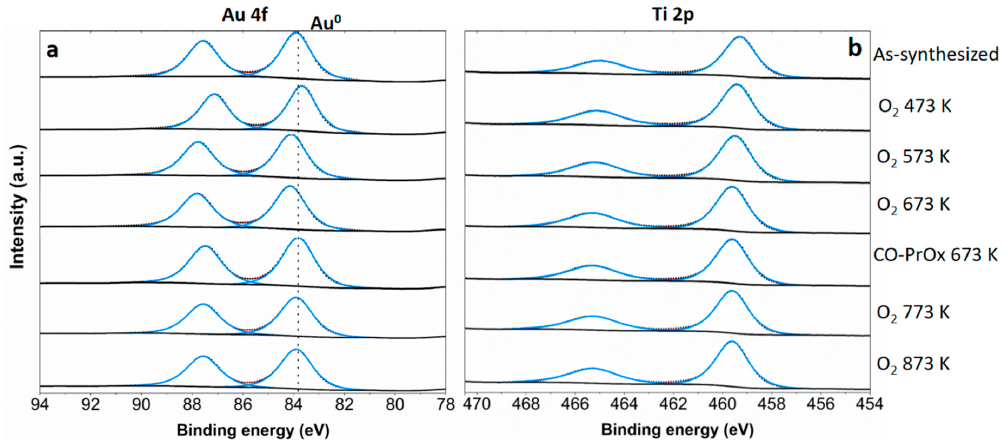
Figure 3. XPS spectra of Au@G0/TiO 2 acquired during the in situ series after the treatments (gases and temperatures) indicated on the plot. ( a ) Au 4f, ( b ) Ti 2p spectral regions.